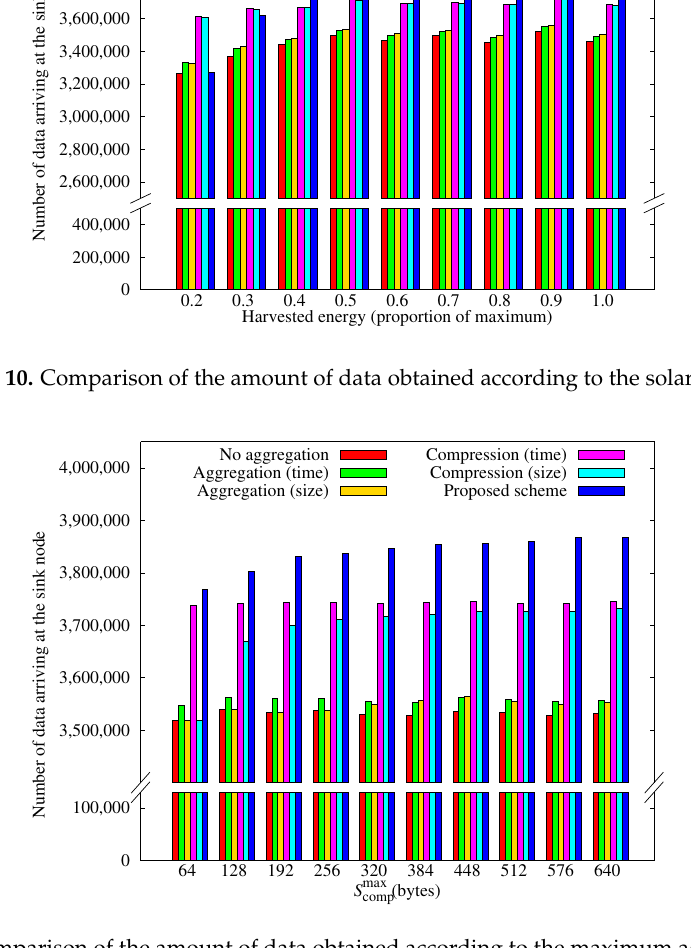
Figure 11. Comparison of the amount of data obtained according to the maximum aggregation